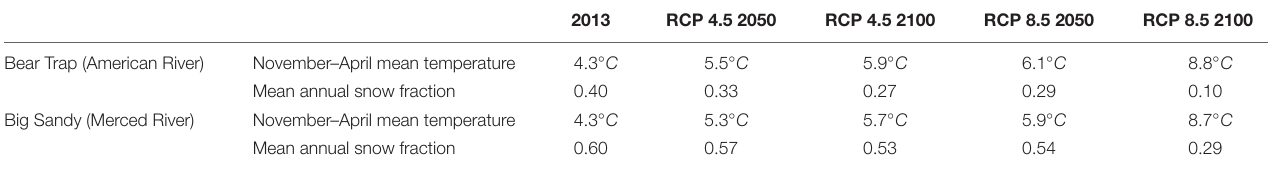
TABLE 1 | Mean daily temperatures for the months of highest precipitation (November–April) and the fraction of precipitation falling as snow under each climate